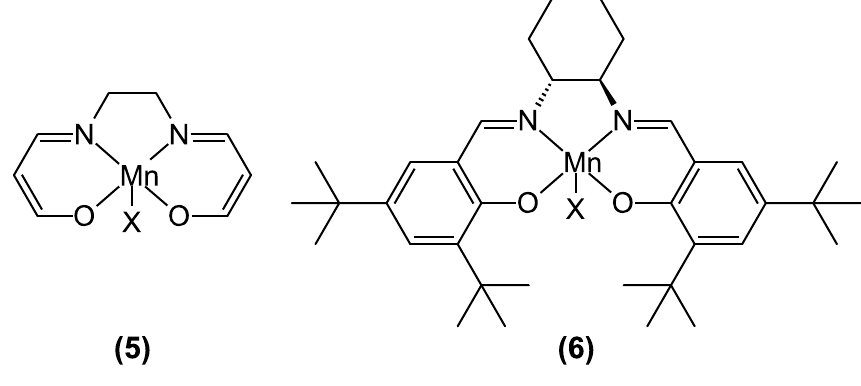
Figure 2. General formulae of Mn(acacen) ( 5 ); and the Jacobsen catalyst ( 6